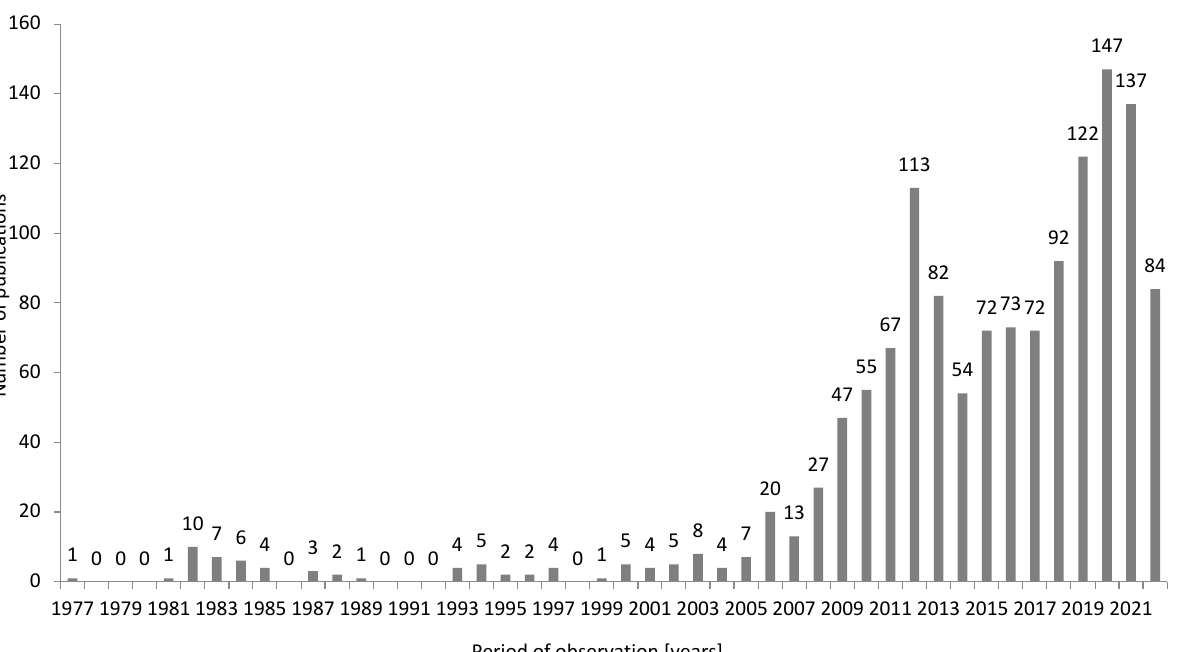
Figure 3. The number of publications per year.